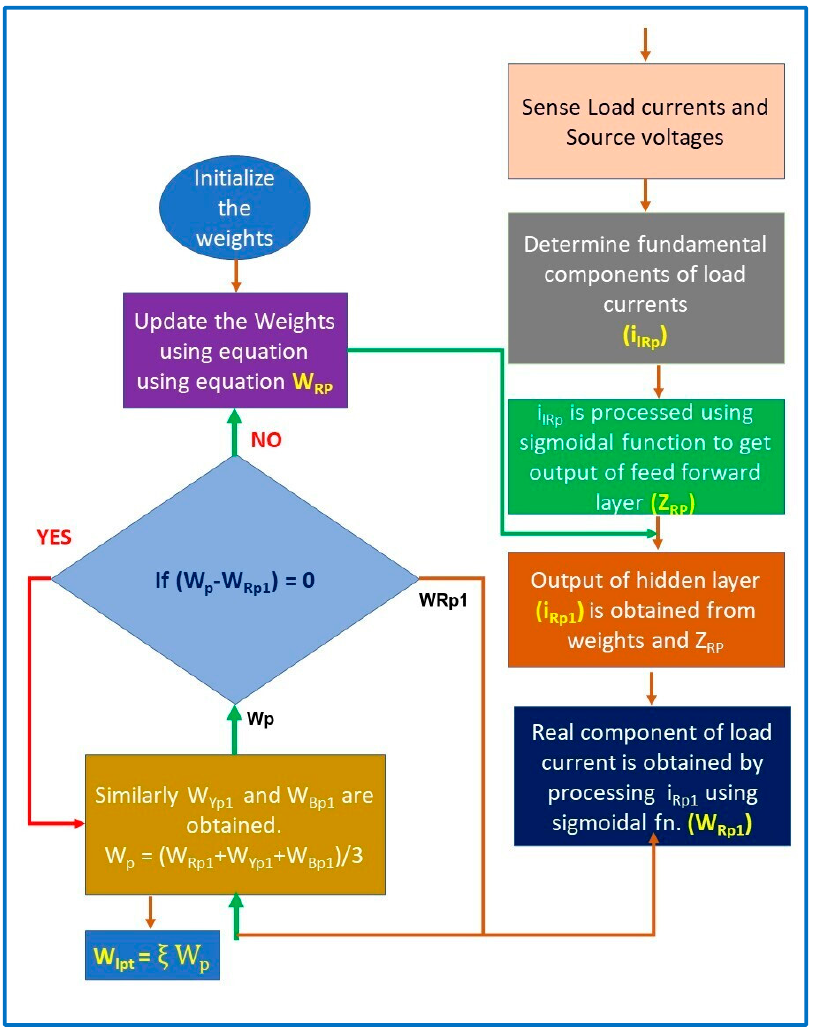
Figure 9. Flowchart of the ANN-BP algorithm.